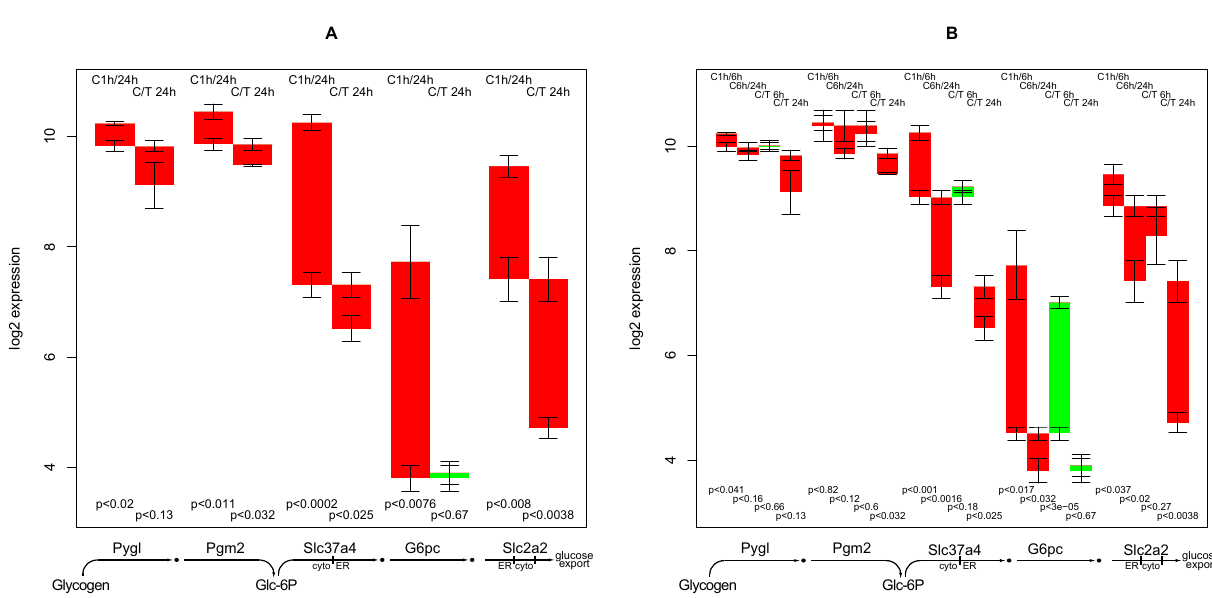
Figure 6 . Regulation of genes involved in glucose release from